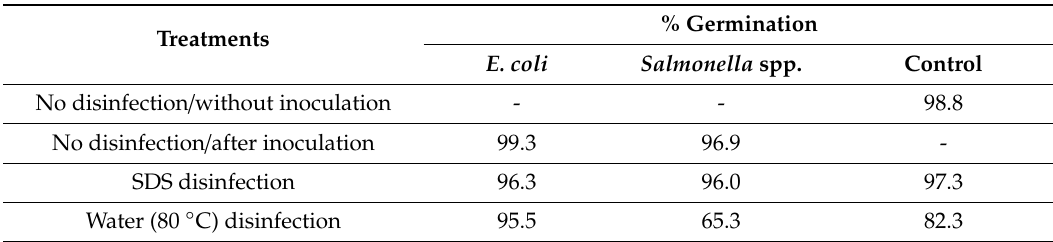
Table 2. Germination percentage after disinfection treatments in lentil seeds (variety Rosana) inoculated with E. coli , Salmonella spp. and control.